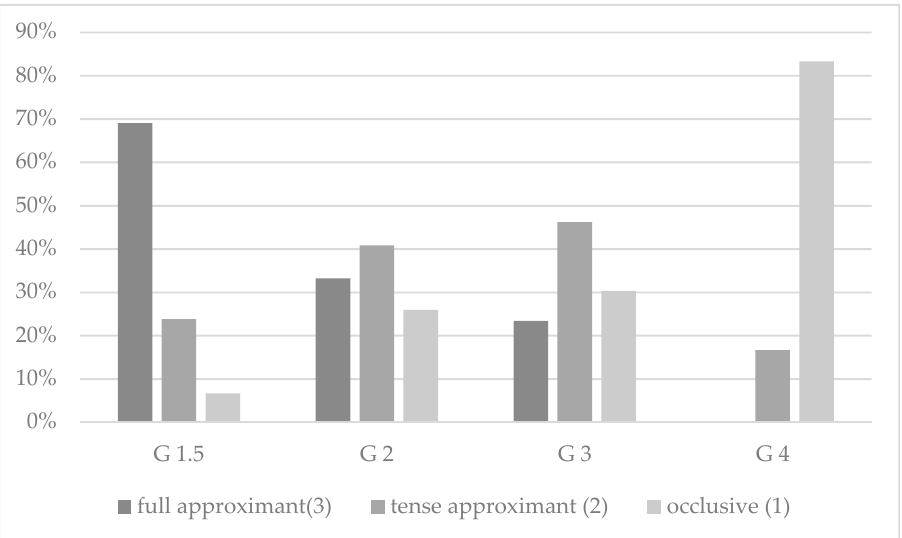
Figure 5. Rates of production types for each generation.